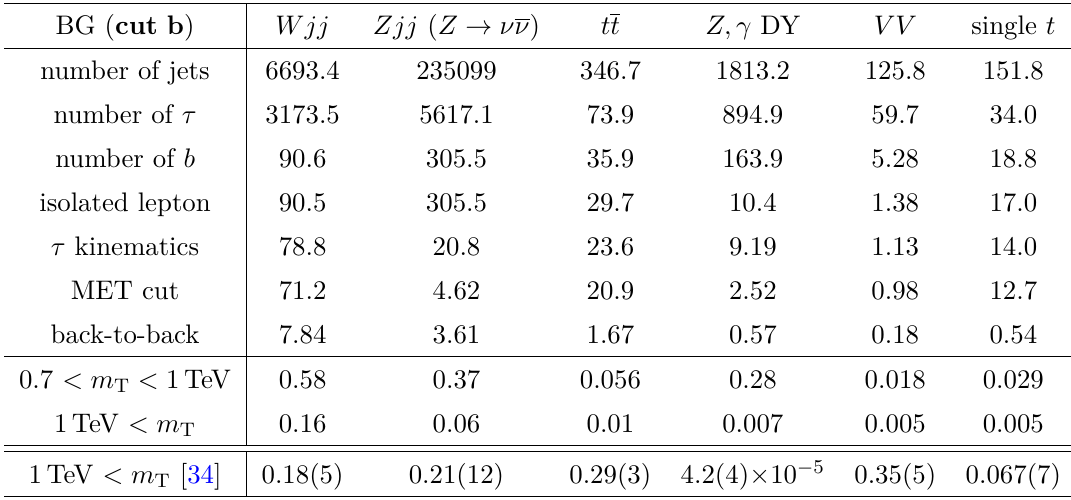
Table 10 . Same as table 9 but for cut b (the τ ± ν + b search). The last row shows the results by ref. [34]. Note that their b -tagging efficiencies are different from ours (see, the footnote 3).